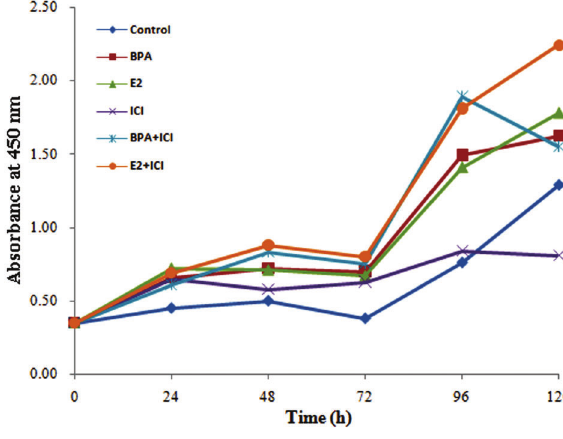
Figure 3. Growth curve of HepG2 cells treated with bisphenol A (BPA) or estradiol (E2) alone or in combination with the anti- estrogen ICI 182,780 (ICI).